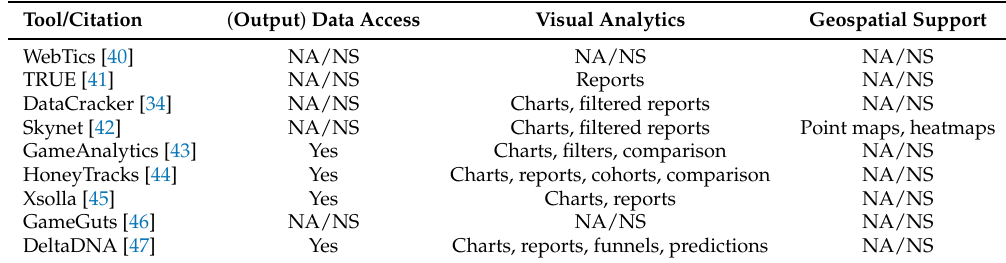
Table 7. Comparison of data reporting and visualization related features among academic and commercial tools for game analytics. NA/NS=Not Applicable,Not Specified or